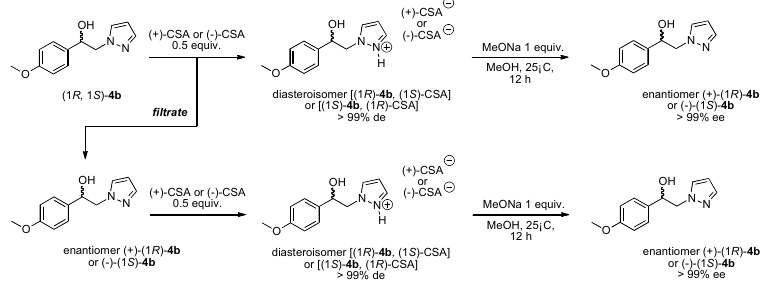
Figure 2. Ortep diagram of (+)-(1 R ) 1-(4-methoxyphenyl)-2-(1 H -pyrazol-1-yl)ethan-1-ol 4b /(+)-(1 S )-10-camphorsulfonic acid obtained by X-ray diffraction. During the resolution of the (±) racemic mixture 4b by the “half-quantities” protocol with ( − )-(1 R )-CSA or (+)-(1 S )-CSA and neutralization of the two diastereomers, all these compounds were submitted to chiral HPLC analysis with a Chiracel OJ-H column (250 × 4.6 i.d. mm) and a